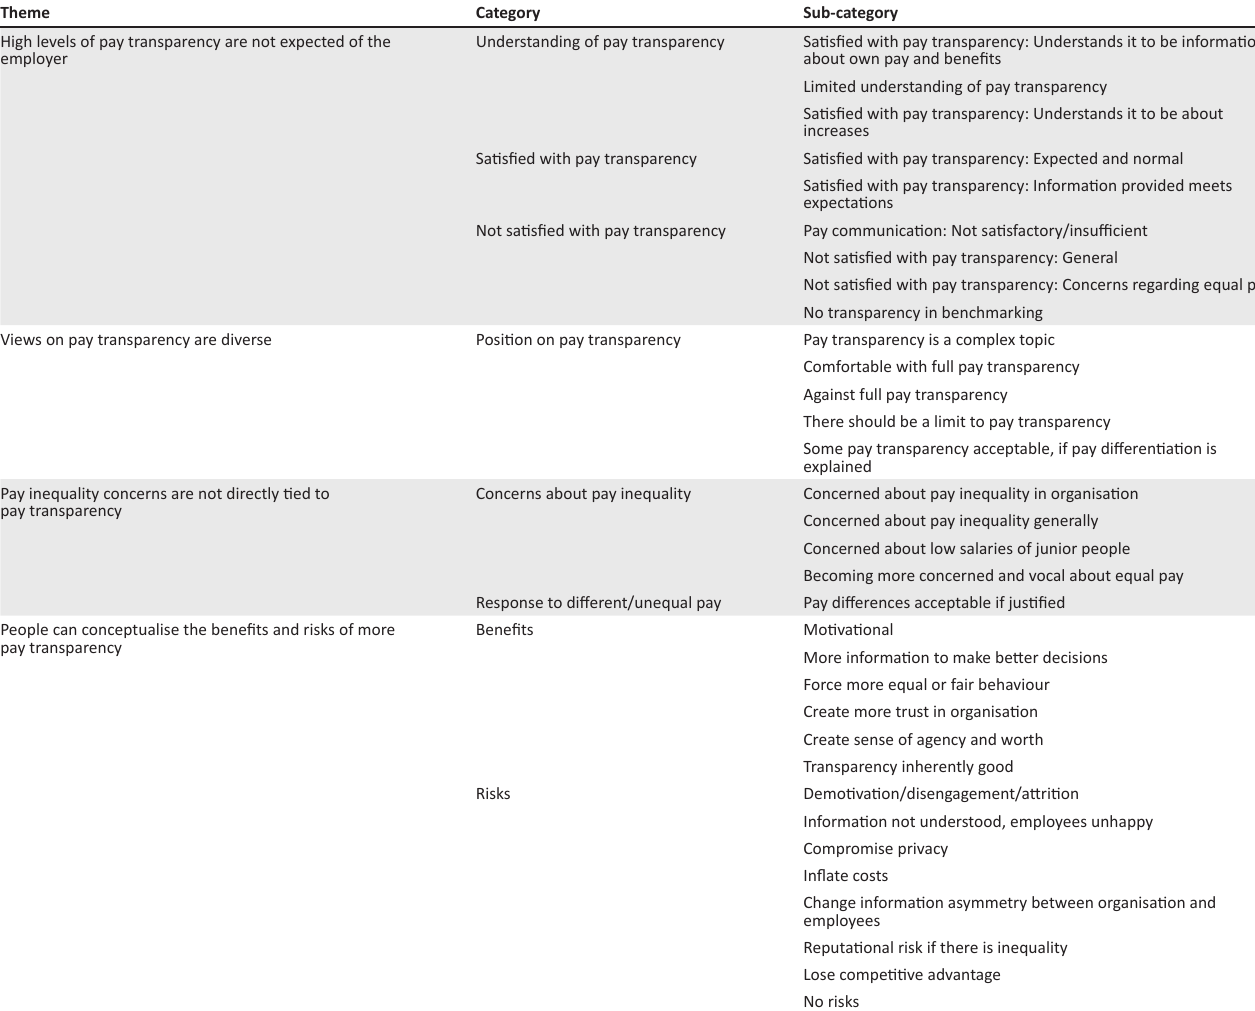
TABLE 2: Pay transparency themes, categories and subcategories. Theme